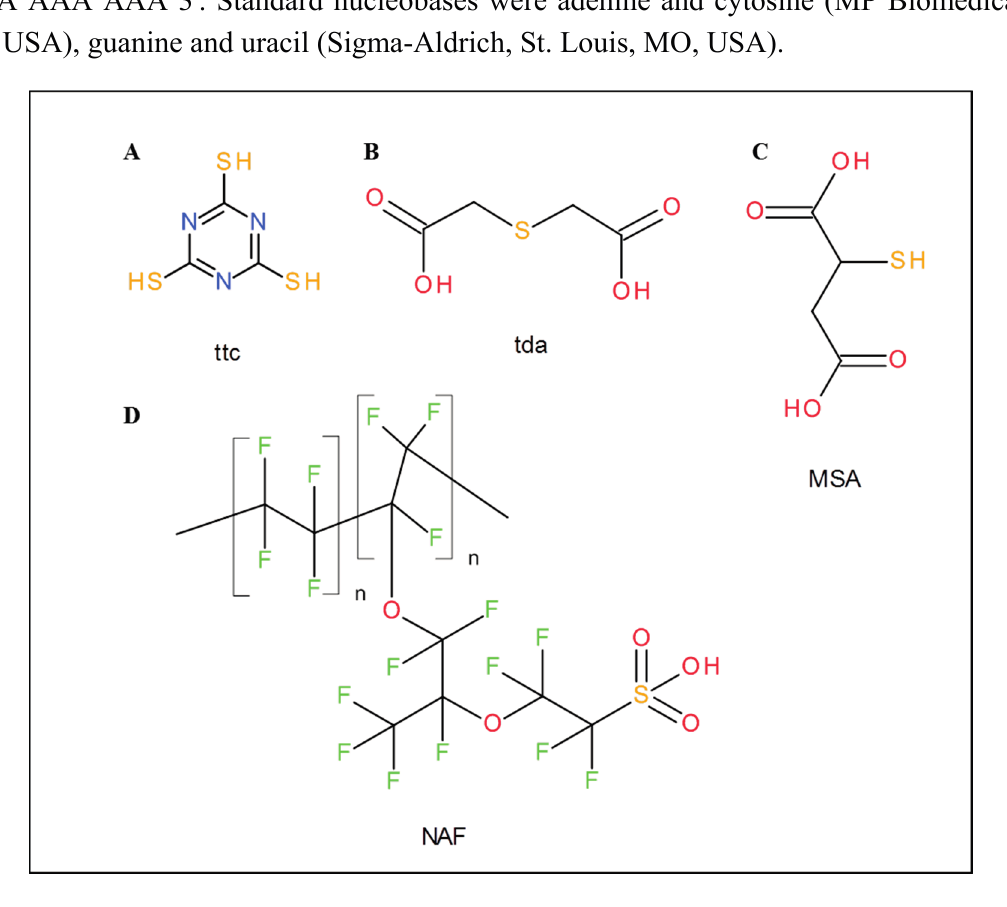
Figure 1. Schemes of compounds used for modification of graphene oxide. ( A ) ttc; ( B ) tda; ( C ) MSA; ( D ) Nafion